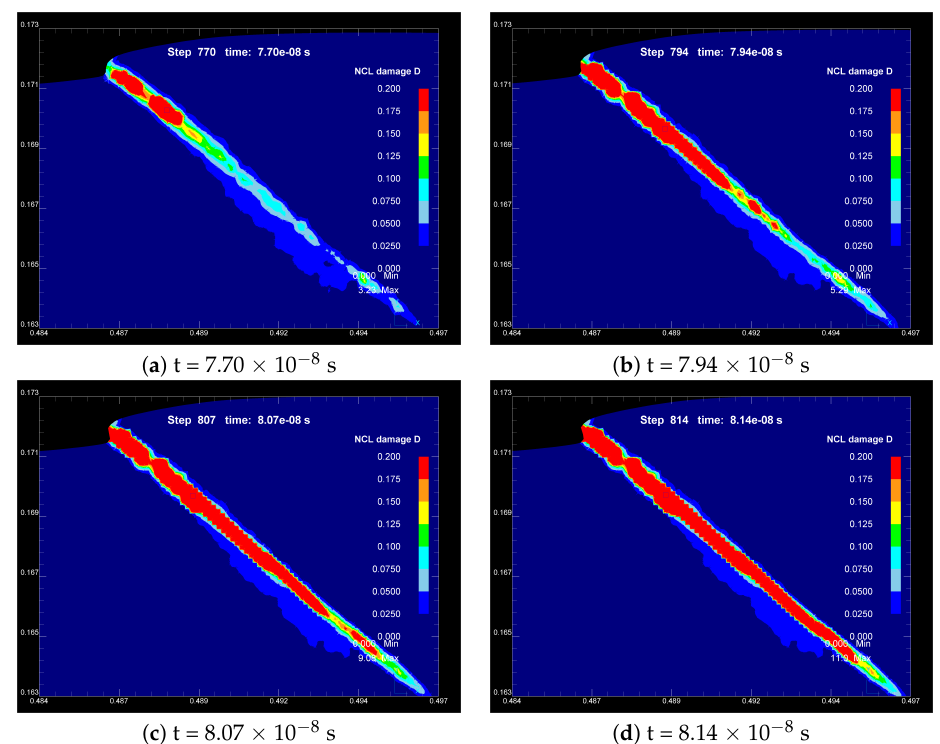
Figure 10. Iso-surfaces of the integral D revealing the discontinuous degradation and coalescence mechanism inside ASB; minimum element size h ≈ 0.1 µ m; simulations using the NCL damage criterion (CDV = 0.2); cutting conditions: v = 60 m/s, feed = 0.01 mm/rev, rake angle γ = 0 ◦ ; snapshots are taken at: ( a ) t = 7.70 × 10 − 8 s, ( b ) t = 7.94 × 10 − 8 s, ( c ) t = 8.07 × 10 − 8 s, and ( d ) t = 8.14 × 10 − 8 s.